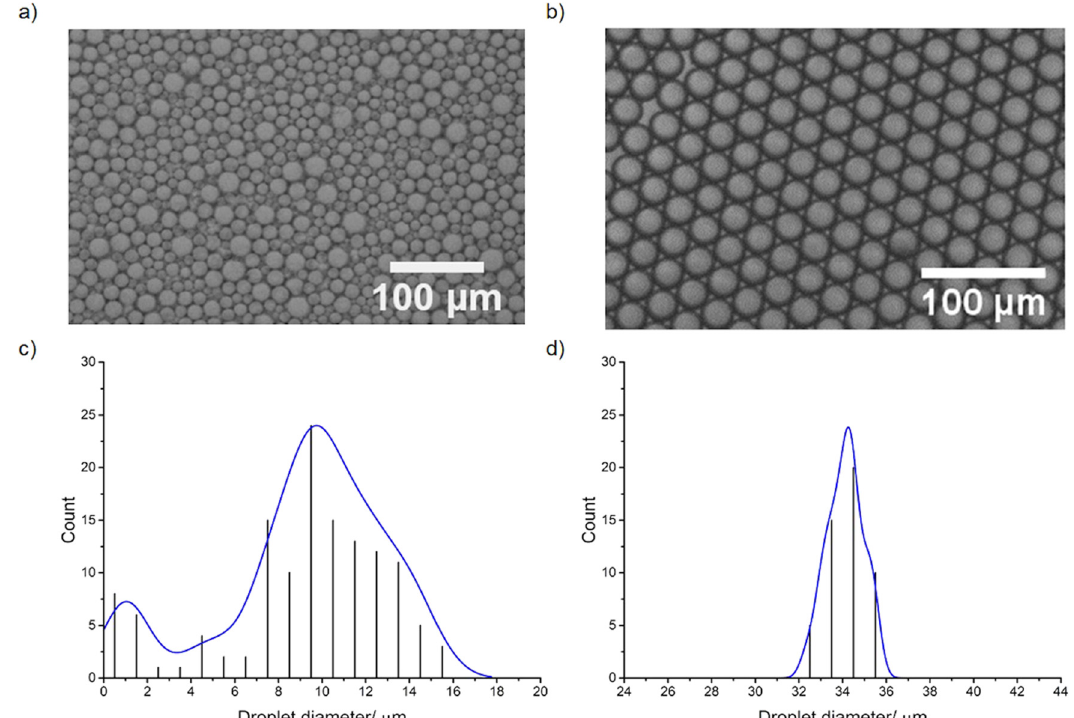
Figure 6: Size distribution of emulsion droplets produced by standard and micro fl uidic methods. ( a and b ) Optical microscopic images of o/w emulsions produced by ( a ) homogenizer and ( b ) micro fl uidic chip ( Q c = 100 μ L/min, Q d = 5 μ L/min ) . ( c and d ) Histograms of droplet size distribution from ( a and b ) analyzed by ImageJ for ( c ) homogenized and ( d ) micro fl uidic chip produced droplets ( Q c = 100 μ L/min, Q d = 5 μ L/min ) [ 61 ]